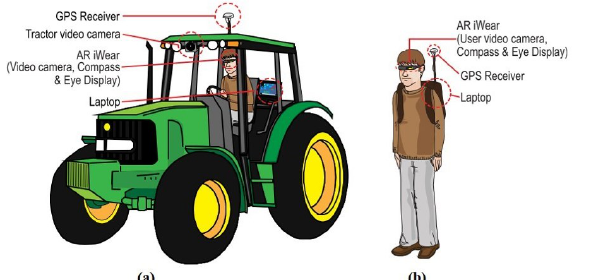
Figure 7. AR-based positioning assist system: ( a ) tractor mounted, ( b ) manual mounted